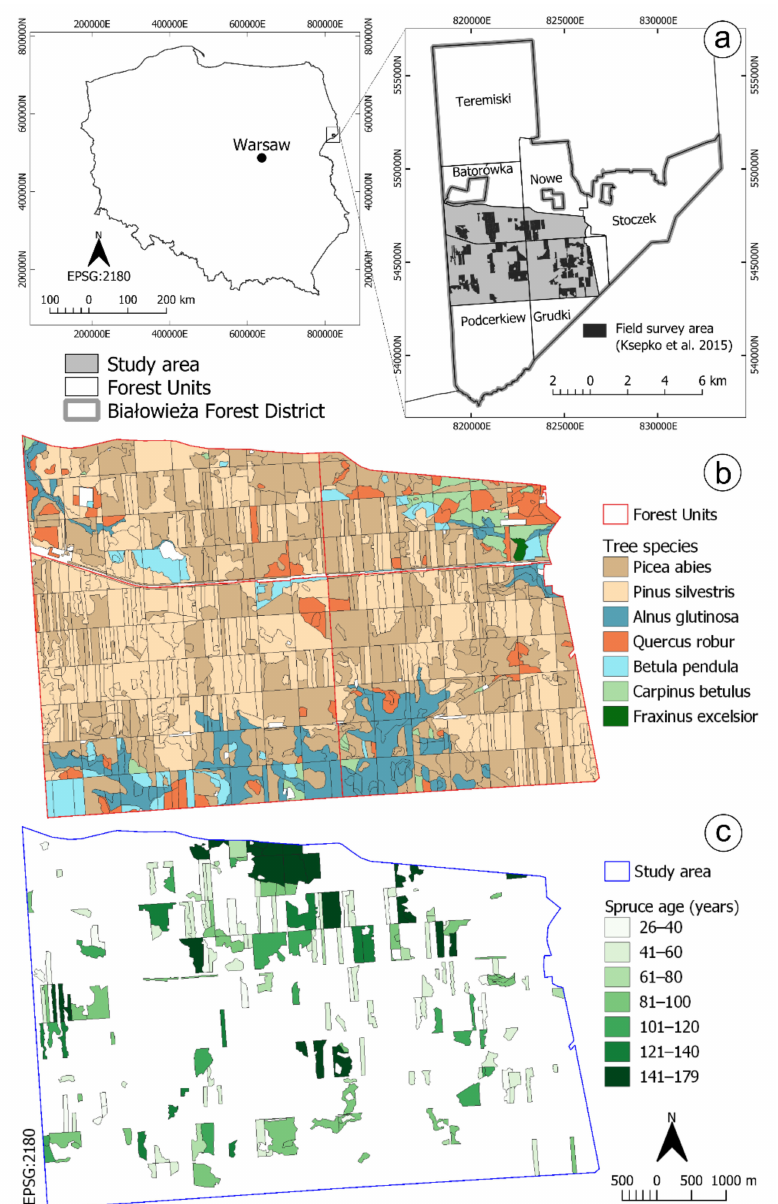
Figure 1. ( a ) Location of the study area. ( b ) Tree species in the studied area. ( c ) Age of the studied spruce